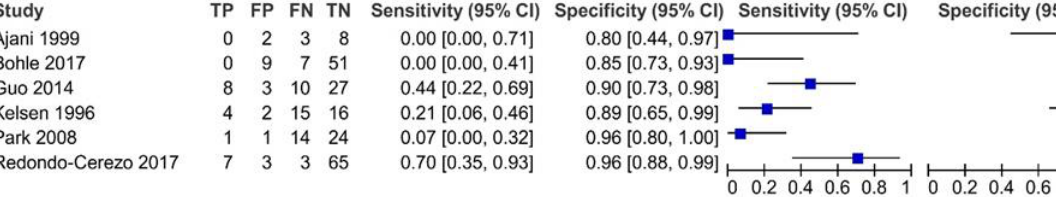
Figure 4. Forest plot for T2 restaging.